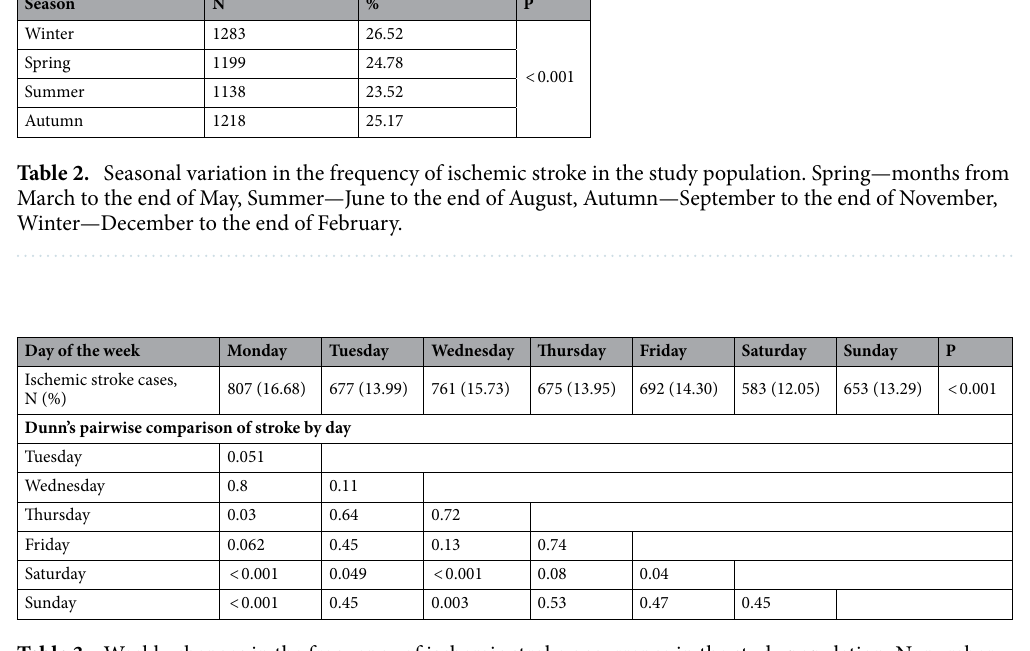
Table 3. Weekly changes in the frequency of ischemic stroke occurrence in the study population. N; number.